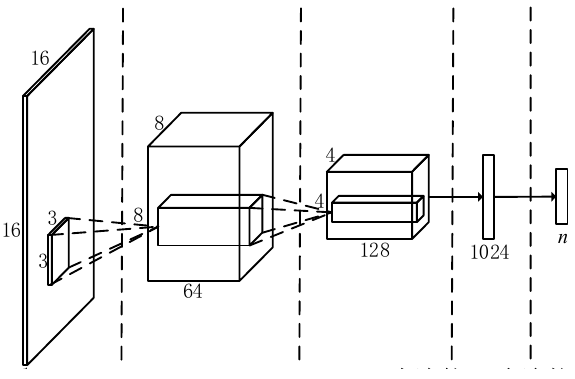
Figure 2. Overall architecture of convolutional neural network.